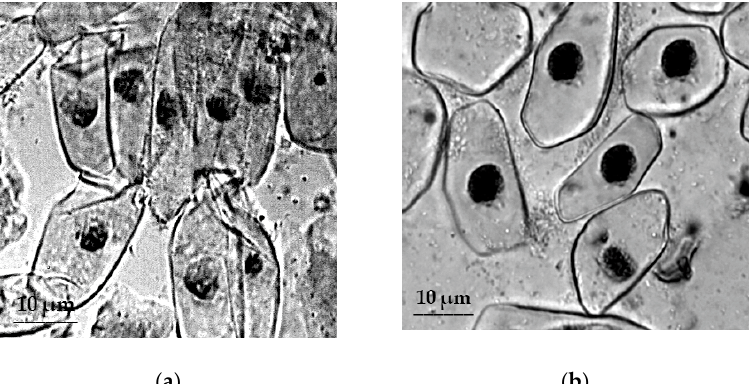
Figure 4. The effect of induced water deficit on RAM cells T. dicoccum : ( a ), control, ( b ), stress (sucrose, 17.6%, 72 h), scale bar = 10 µm.